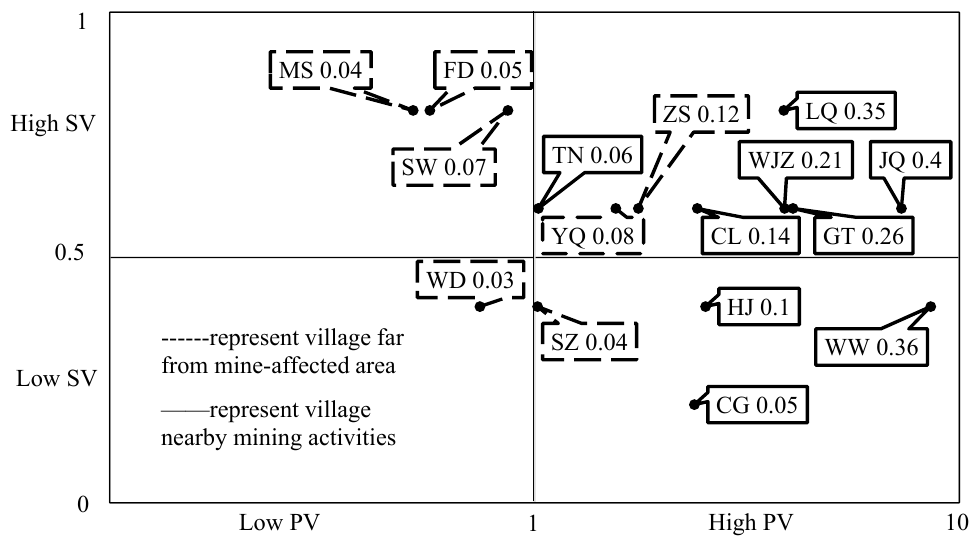
Figure 4. Four-quadrant grading for comprehensive assessment of population health vulnerability (SV = social vulnerability; PV = physical vulnerability).